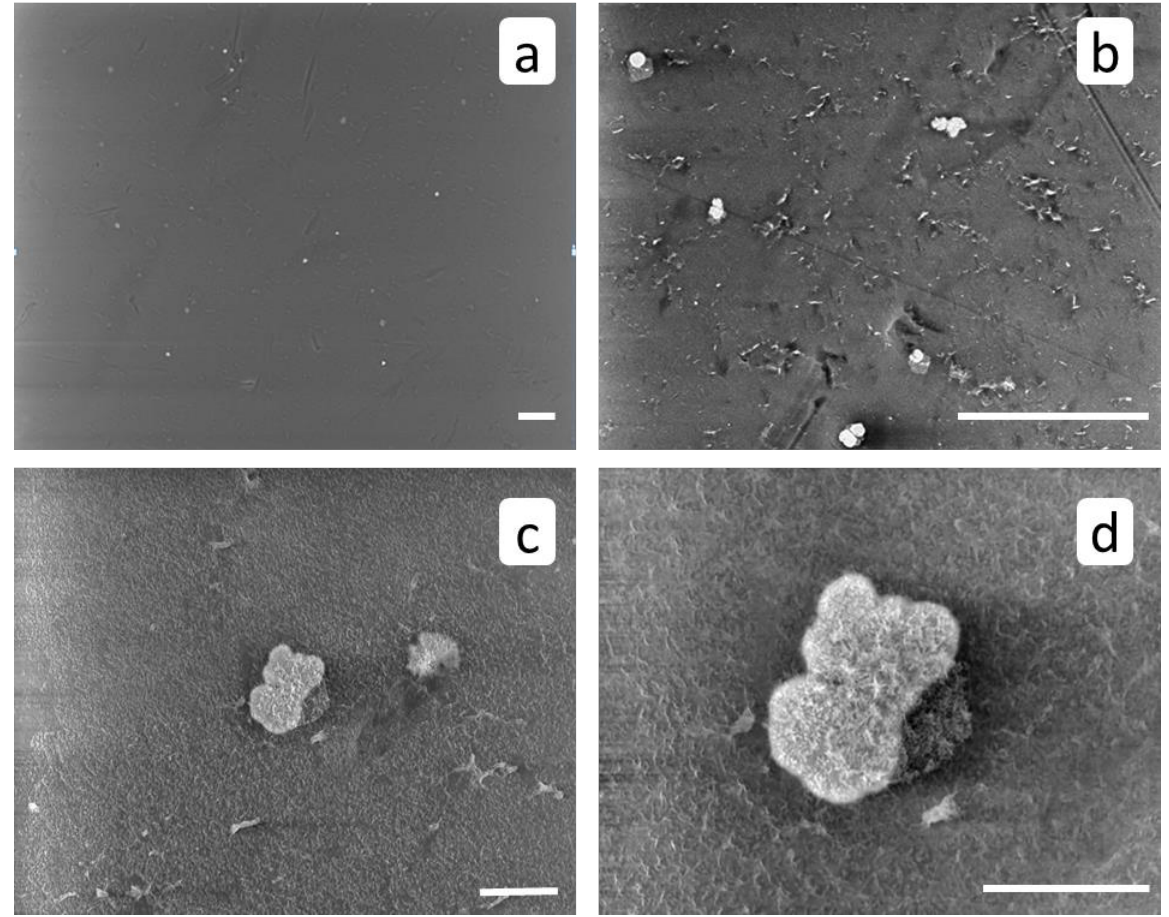
Figure 10. SEM images of membrane surface after RO treatment in presence of PAA-F1; Scale marker corresponds to 100 μm ( a , b ); or to 10 μm ( c , d ).